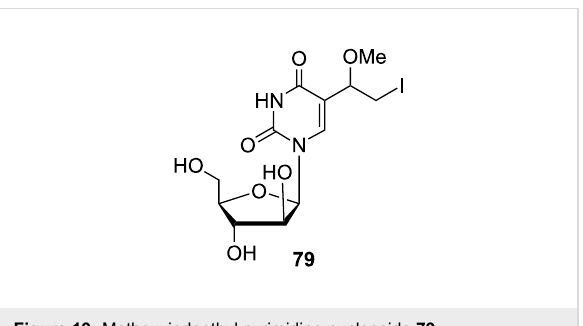
Figure 19: Methoxyiodoethyl pyrimidine nucleoside 79 .